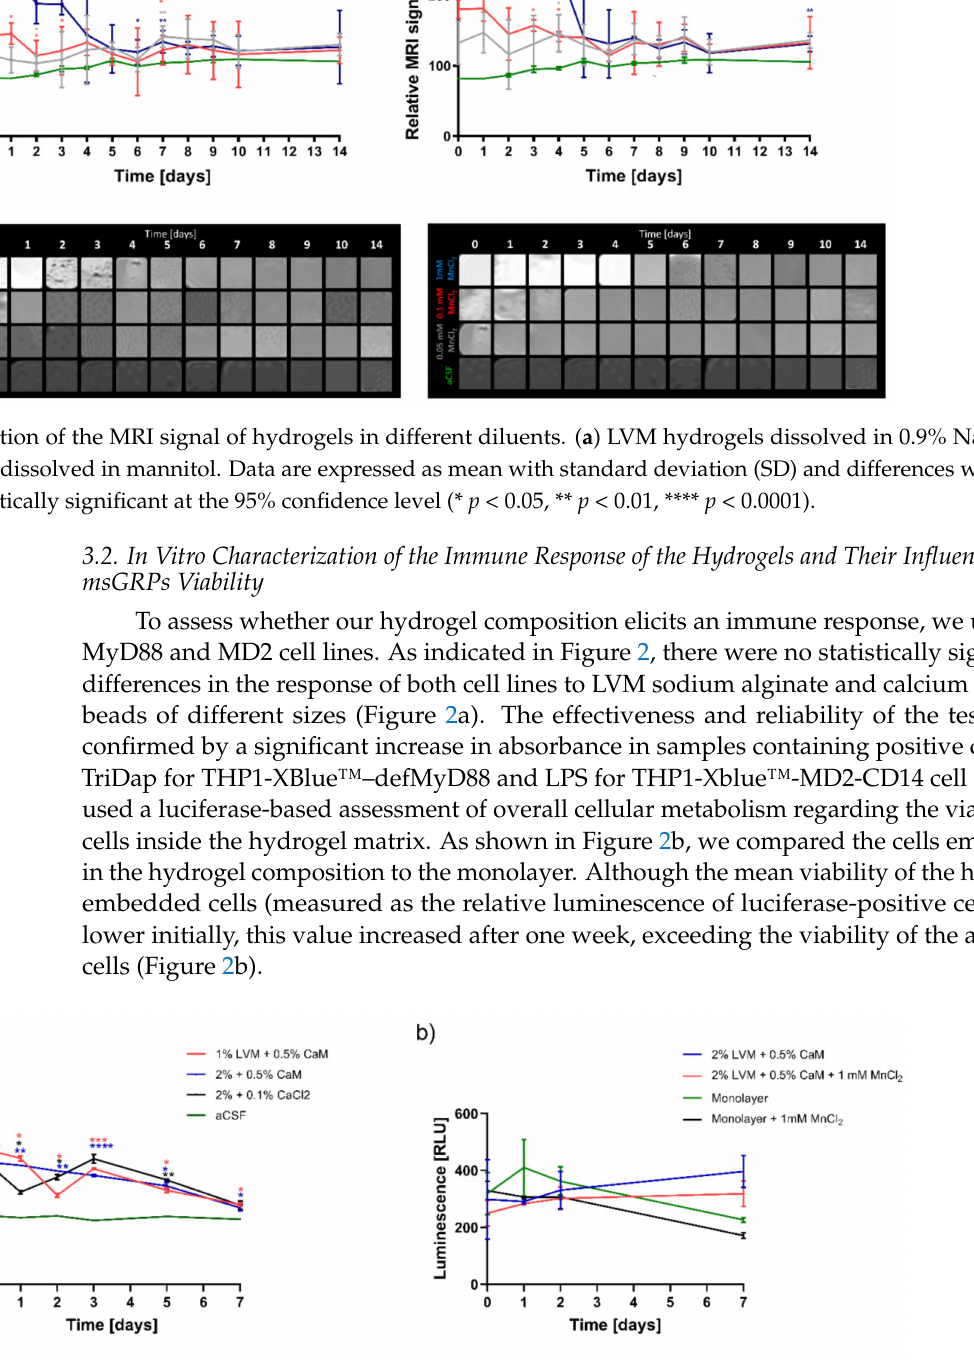
Figure 2. Hydrogels immune response and their influence on the GRP cells viability. ( a ) Response of the THP1-XBlue™- MD2-CD14 and THP1-Xblue™ -defMyD cells on the hydrogel components. ( b ) Viability of the GRPs embedded in the LVM hydrogels. Data are expressed as mean with standard deviation (SD) and differences were considered as statistically significant at the 95% confidence level (* p < 0.05, ** p < 0.01, *** p < 0.001 **** p <